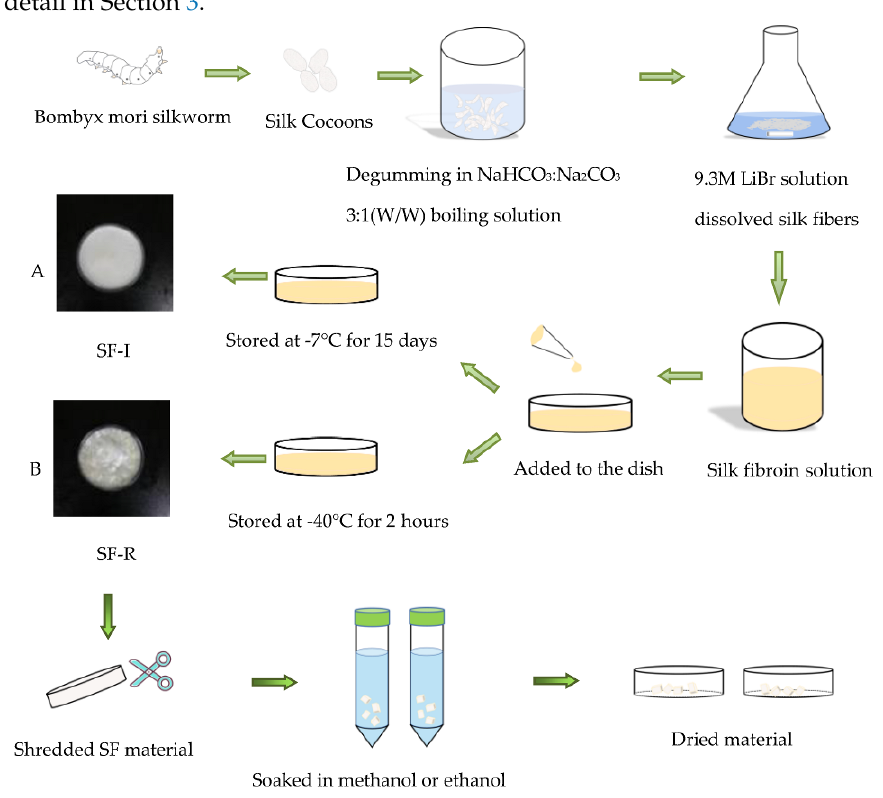
Figure 10. Experimental procedure to prepare ( A ) Silk I crystalline structure dominated silk materials, and ( B ) uncrystallized (randomly coils dominated) silk materials.